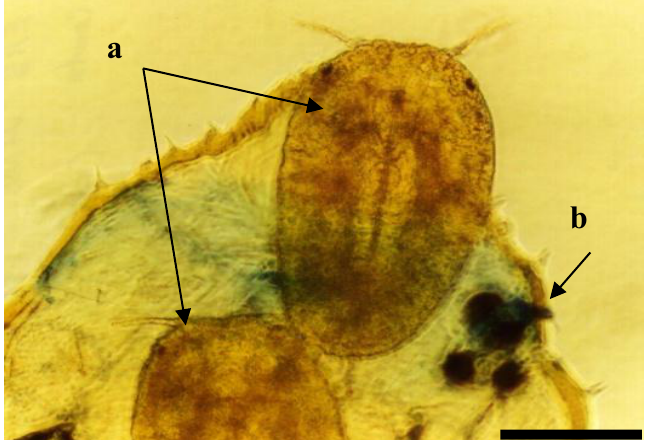
Figure 3. Elongate hemlock scale crawlers (a: 1st mobile instar) exiting from female body (b: outline of female body) containing sclerotia of Myriangium duriaei ; phase contrast, objective ×10. (Bar = 0.5